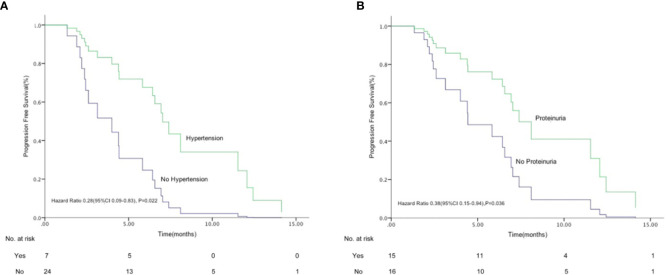
Kaplan-Meier graph for progression-free survival in patients who had hypertension (A) and proteinuria (B) (n=31). (A) Median progression free survival (PFS) in patients with hypertension was significantly longer than that in patients without hypertension [7.4 months (95% CI 6.0–8.4) versus 2.6 months (95% CI 2.2–3.0), hazard ratio (HR) 0.28 (95% CI 0.09–0.83), p = 0.022)]. (B) Median PFS was also significantly longer in patients with proteinuria than those without proteinuria [8.1 months (95% CI 2.4–13.9) versus 4.0 months (95% CI 0.1–7.9), HR 0.38 (95% CI 0.15–0.94), p = 0.036].